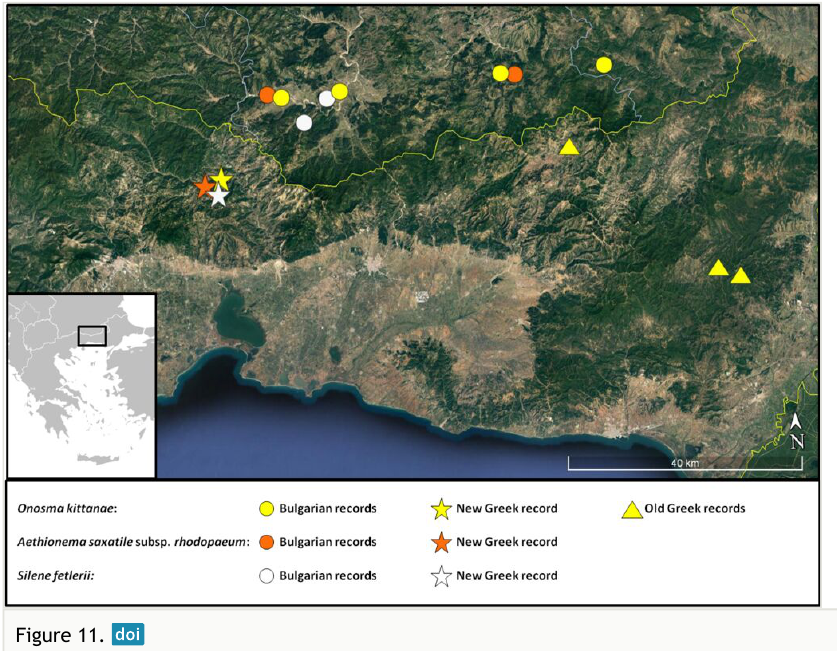
Figure 11. Distribution map of Onosma kittanae , Aethionema saxatile subsp. rhodopaeum and Silene fetlerii in Greece and